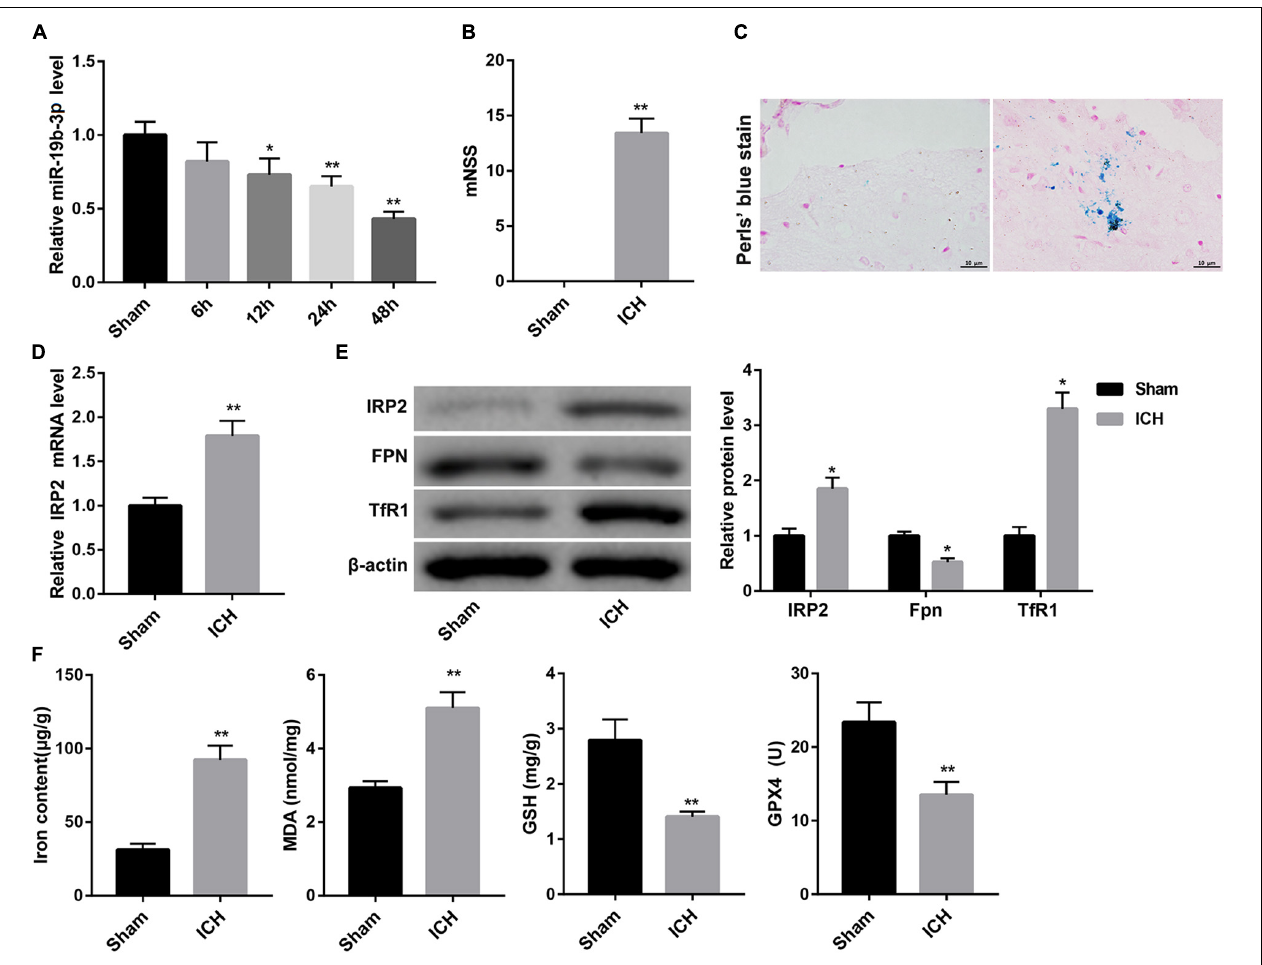
FIGURE 1 | Decreased miR-19b-3p expression and increased ferroptosis in ICH mice. (A) Plasma level of miR-19b-3p in sham-operated mice and ICH model mice at 6, 12, 24, and 48 h after ICH was examined by qRT-PCR. (B) Neurological function at 48 h after ICH in mice was evaluated by mNSS. (C) The iron deposition in the brain at 48 h was determined by Perls’ Prussian blue staining (scale bar: 10 µ m). (D) qRT-PCR analysis of IRP2 mRNA level and (E) western blot analysis of IRP2, FPN, and TfR1 in the brain at 48 h after ICH in mice. (F) The contents of iron, MDA, GSH, and GPX4 in the brain at 48 h after ICH in mice. N = 6 in each group. * P < 0.05, ** P < 0.01, vs. Sham.